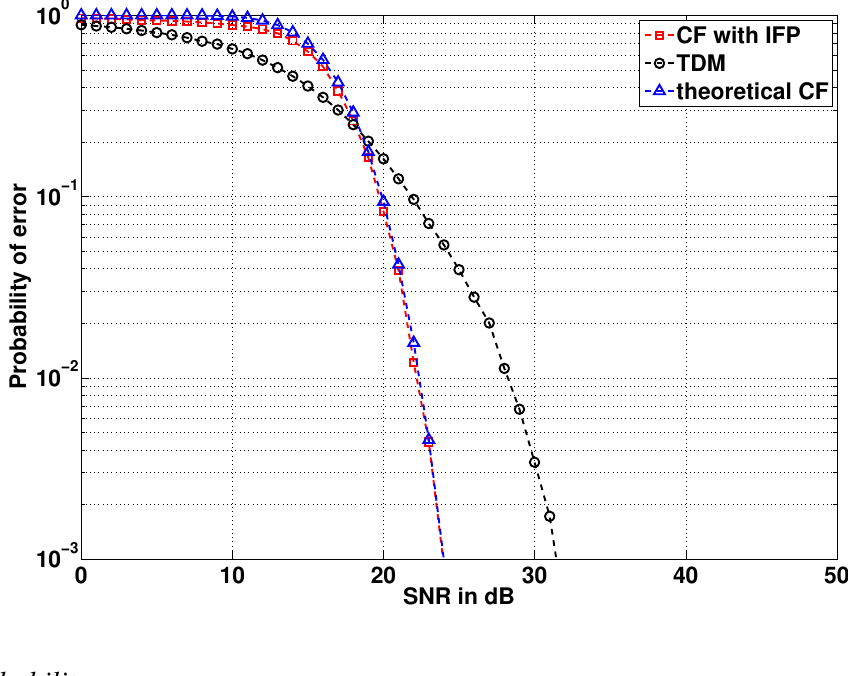
Figure 3. Compute and forward (CF) with the integer forcing precoder (IFP) compared to Time Division Multiplexing (TDM) performance at the